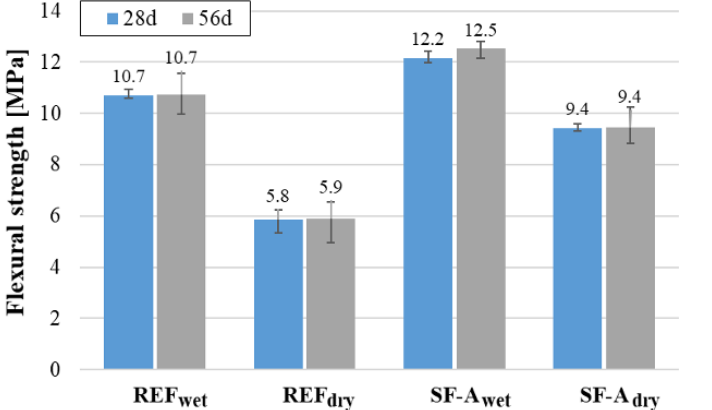
Figure 3. Flexural strength of C120 depending on the test age and preliminary